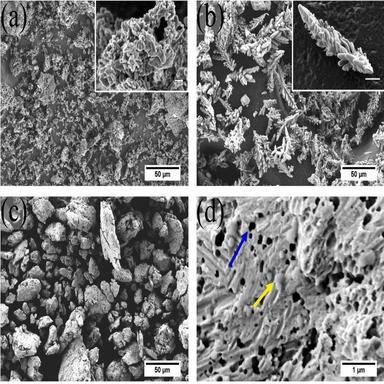
(a) A general overview of the boron powder. The inset in (a) shows the spongy shape of the boron powder. The scale bar is 500 nm in the inset. (b) The initial copper powder exhibits a dendritic morphology. The scale bar is 5 µm in the inset. (c) General overview of the MA'd powder with plate/semi-spherical shape. (d) High magnification image of the MA'd powder. The surface of the MA'd powder contains deformation traces. The yellow arrow shows one boron particle, identified by EDS. The black spherical spots